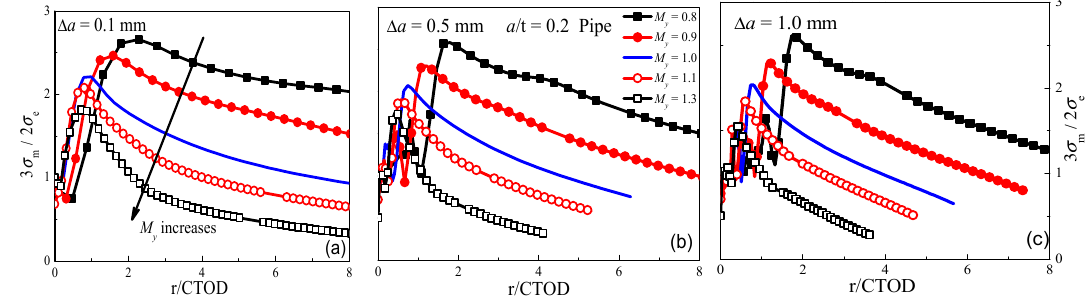
Figure 10. Stress triaxiality distributions ahead of the current crack tip for pipes at different crack propagation, a / t = 0.2, ( a ) ∆ a = 0.1 mm; ( b ) ∆ a = 0.5 mm; and, ( c ) ∆ a = 1.0 mm.